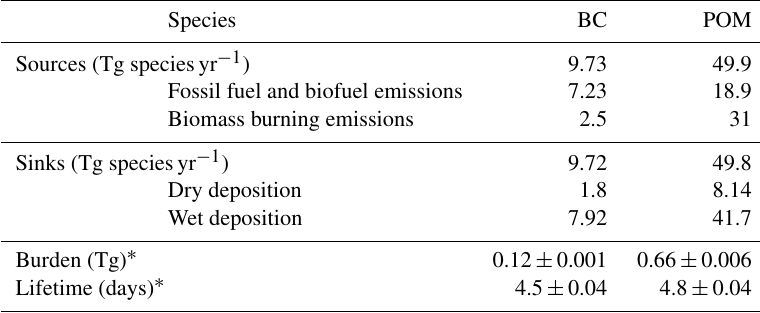
Table 3. Global budgets, burden and lifetime of BC and POM from model control simulations.